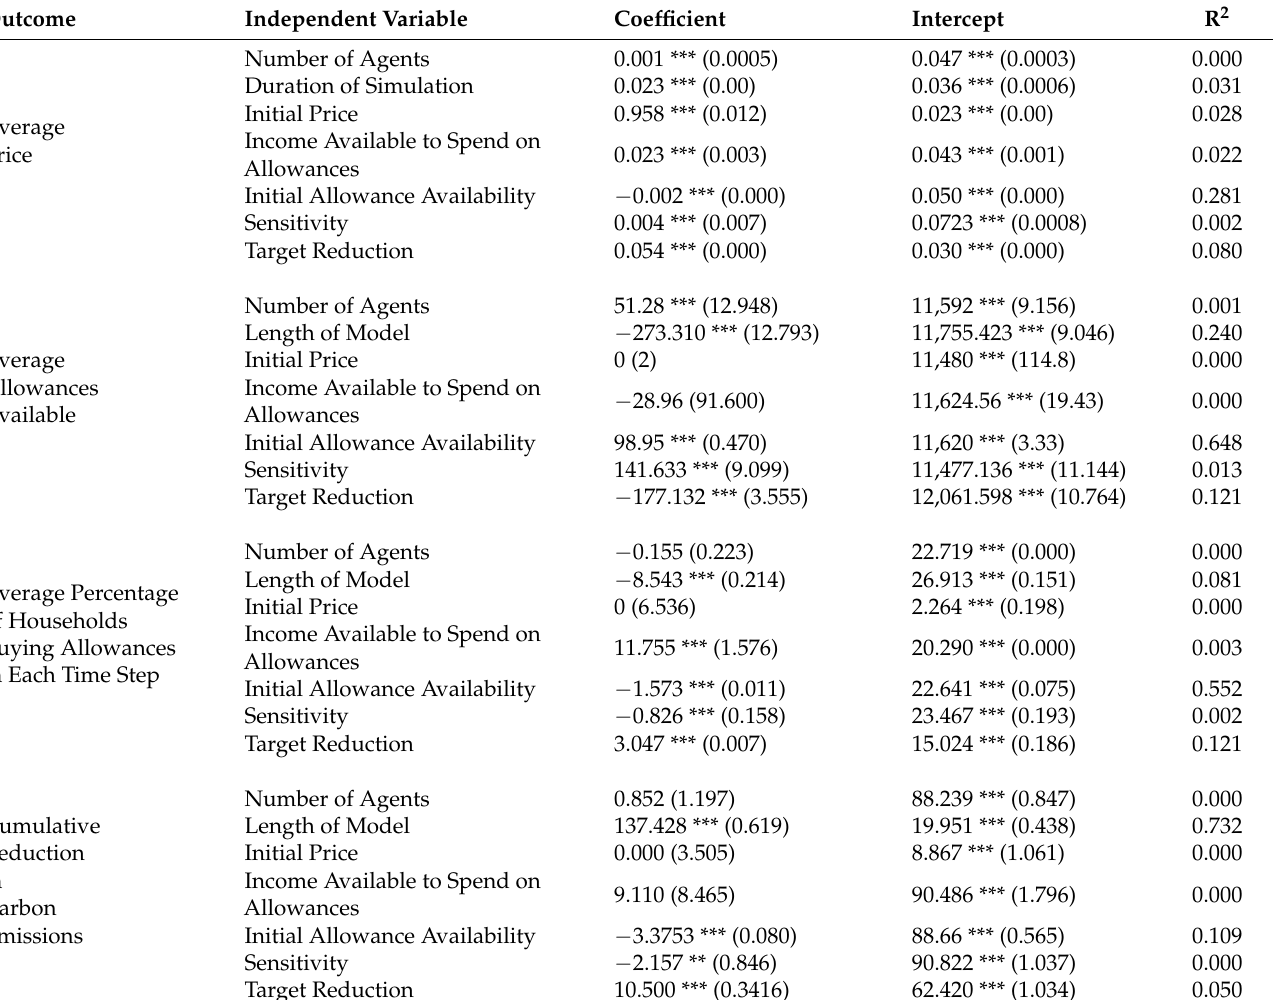
Table 2. Results from a regression analysis on the essential variables (Outcome, first column). *** implies significance at the 1% level, ** at the 5% level. Standard errors in